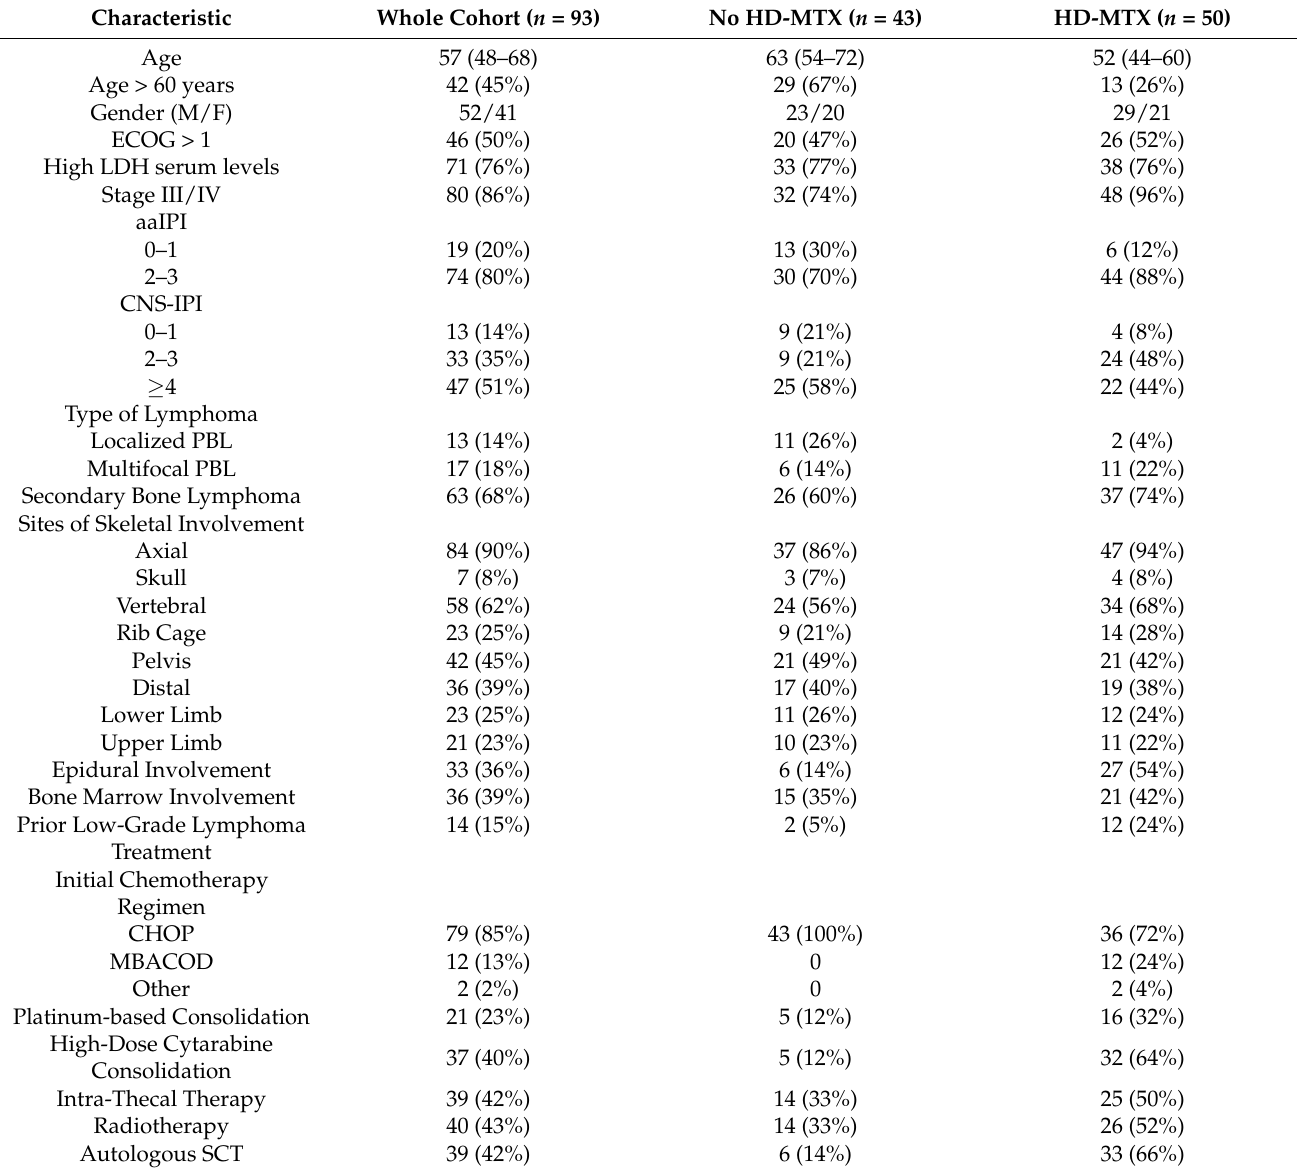
Table 4. Characteristics of the whole cohort and of patients who did or did not receive HD-MTX. Characteristic